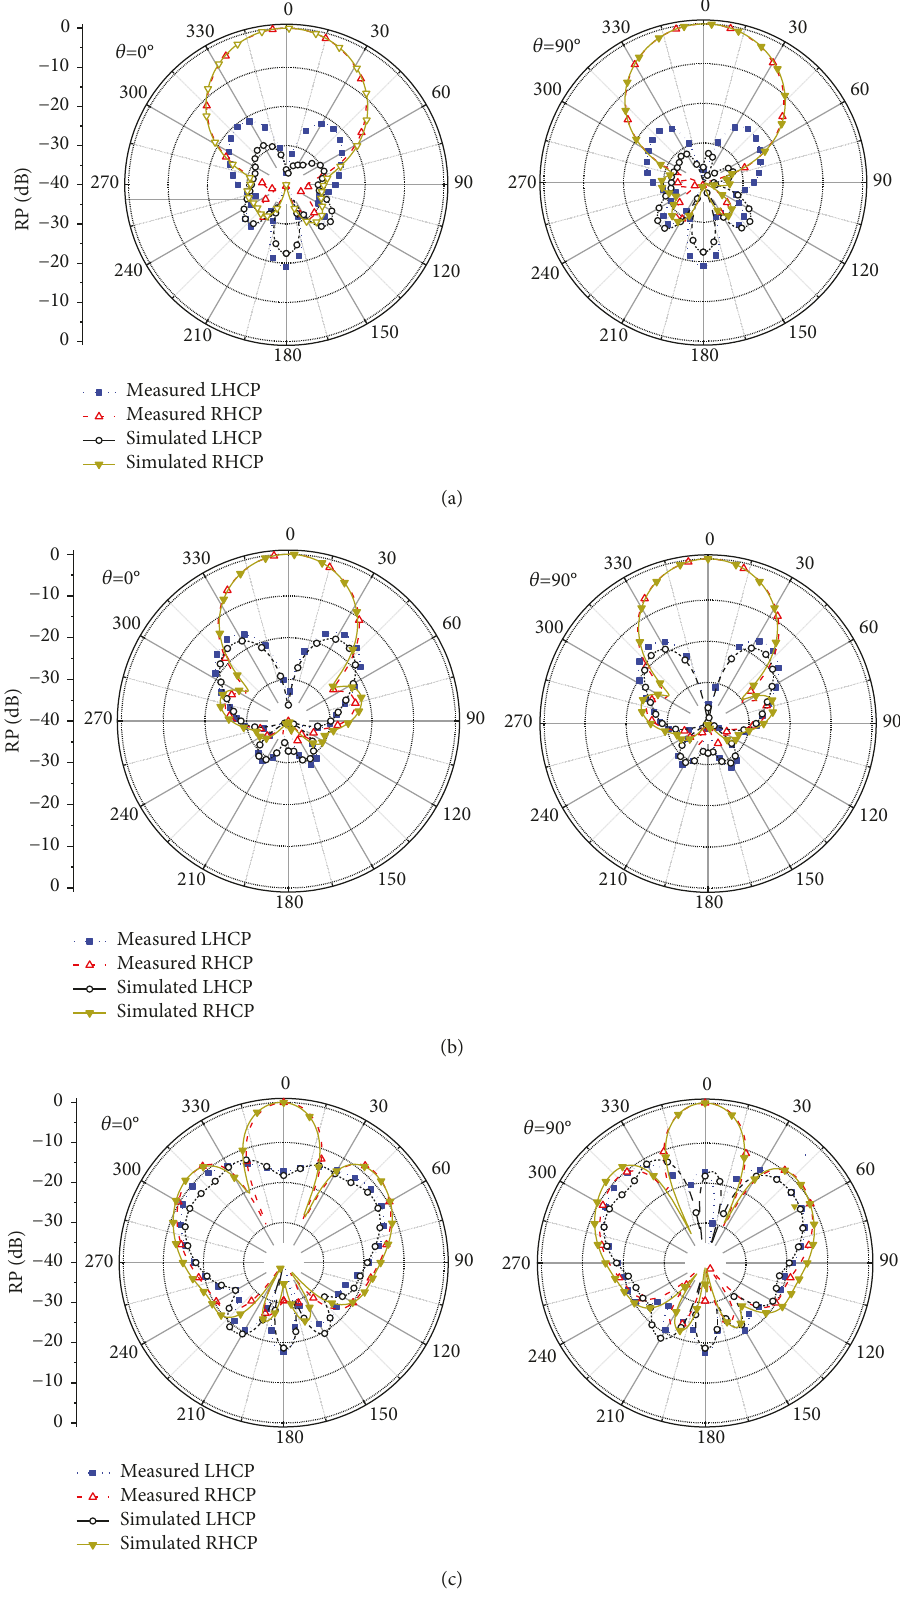
Figure 13: Measured and simulated radiation patterns (RPs) at (a) 1.05GHz, (b) 1.45GHz, and (c)